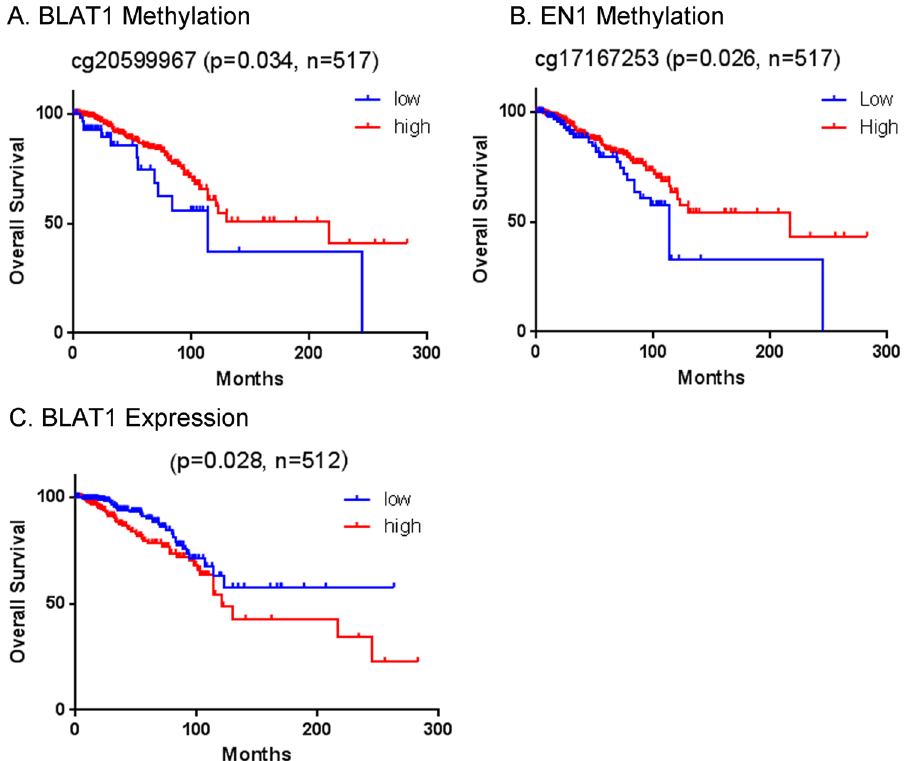
Figure 7. The Promoter Methylation Levels of BLAT1 and EN1 Are Associated with Clinical Outcomes. ( A , B ) The Kaplan–Meier estimator shows poor overall survival in patients with lower levels of the BLAT1 (beta value < 0.2) ( A ) and EN1 ( B ) promoter methylation, compared to those with higher levels of methylation (beta value > 0.2) (p = 0.034 and p = 0.026, respectively). ( C ) Patients with higher expression of BLAT1 ( > median) have worse survival than those with lower expression ( < median) of BLAT1 (p =